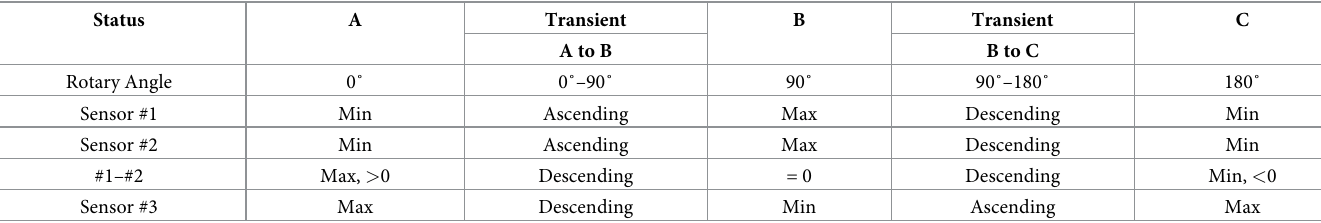
Table 3. Analysis of sensor output in different